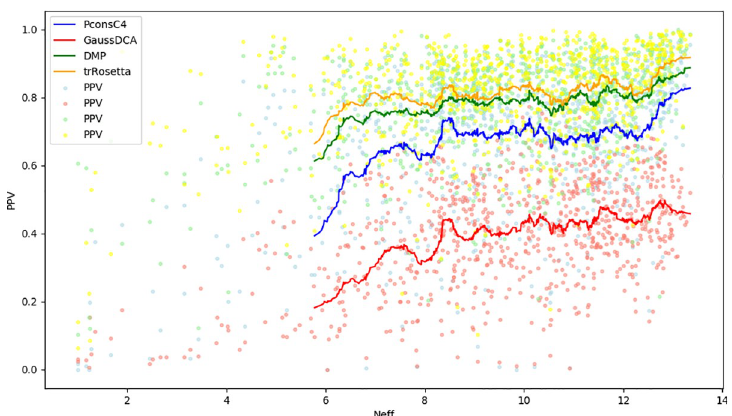
Fig 5. The relation between Precision and the effective number of sequences in the MSA. Positively Predicted Value for trRosetta in orange, GaussDCA in red, PconsC4 in Blue and DeepMetaPsicov in green on the Neff value (the effective number of sequences length weighted with the length of the protein). The single dots correspond to each protein in the datasets, and the line is the running average on (n =